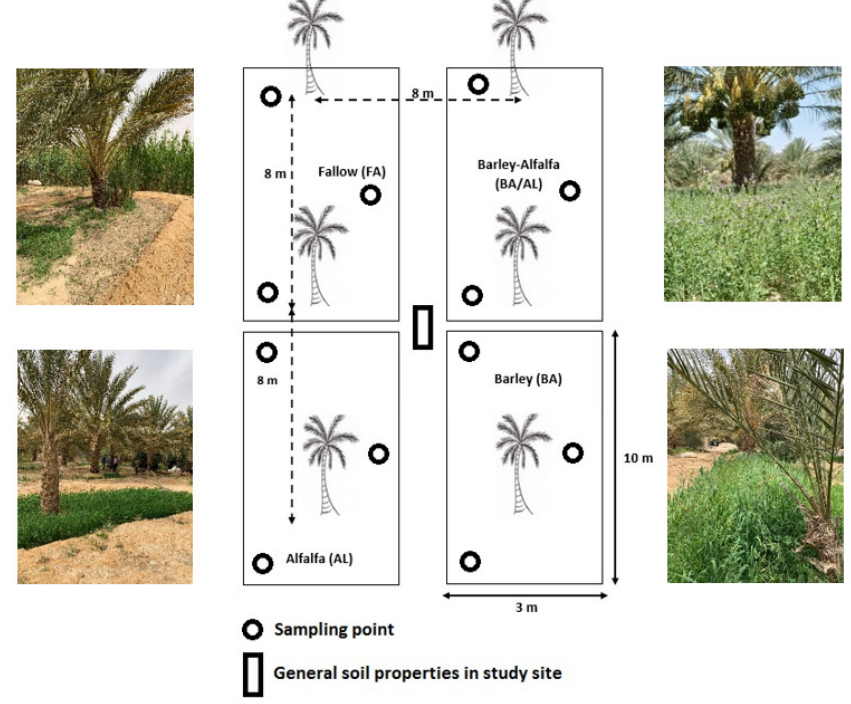
Figure 2. Sampling scheme at the four sub-plots in the study